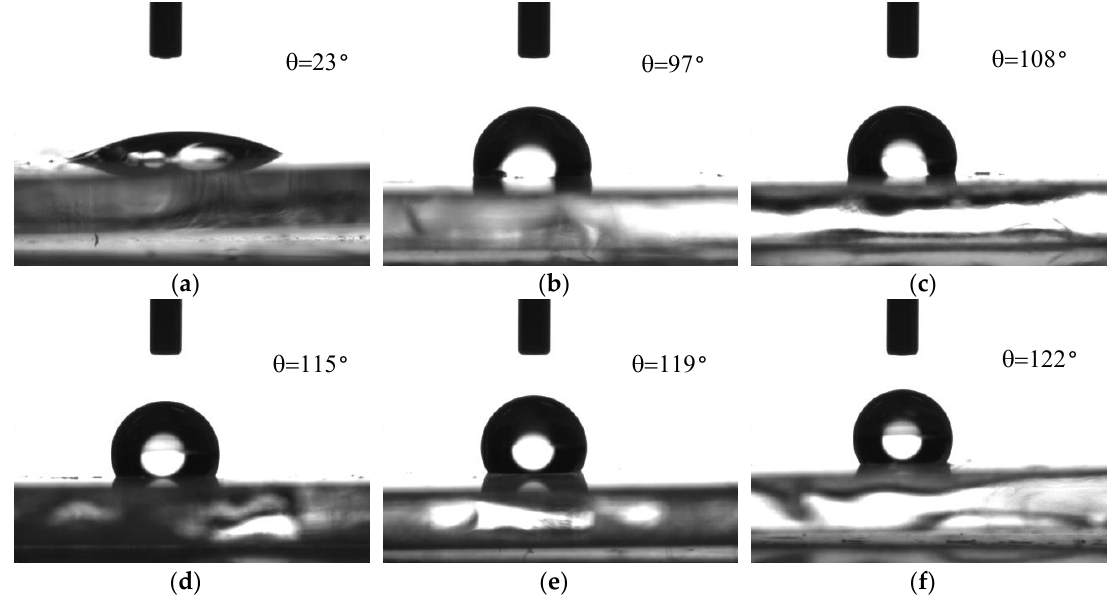
Figure 6. Water drop contact angle profile for: ( a ) clear glass, ( b ) (PAC 18 Na/PDADMAC) 20 , ( c ) (PAC 18 Na-C 10 TAB/PDAMAC) 20 , ( d ) (PAC 18 Na-C 12 TAB/PDAMAC) 20 , ( e ) (PAC 18 Na-C 14 TAB/ PDAMAC) 20 and ( f ) (PAC 18 Na-C 18 TAB/PDAMAC) 20 multilayer films exposed to S. aureus ATCC 25923.